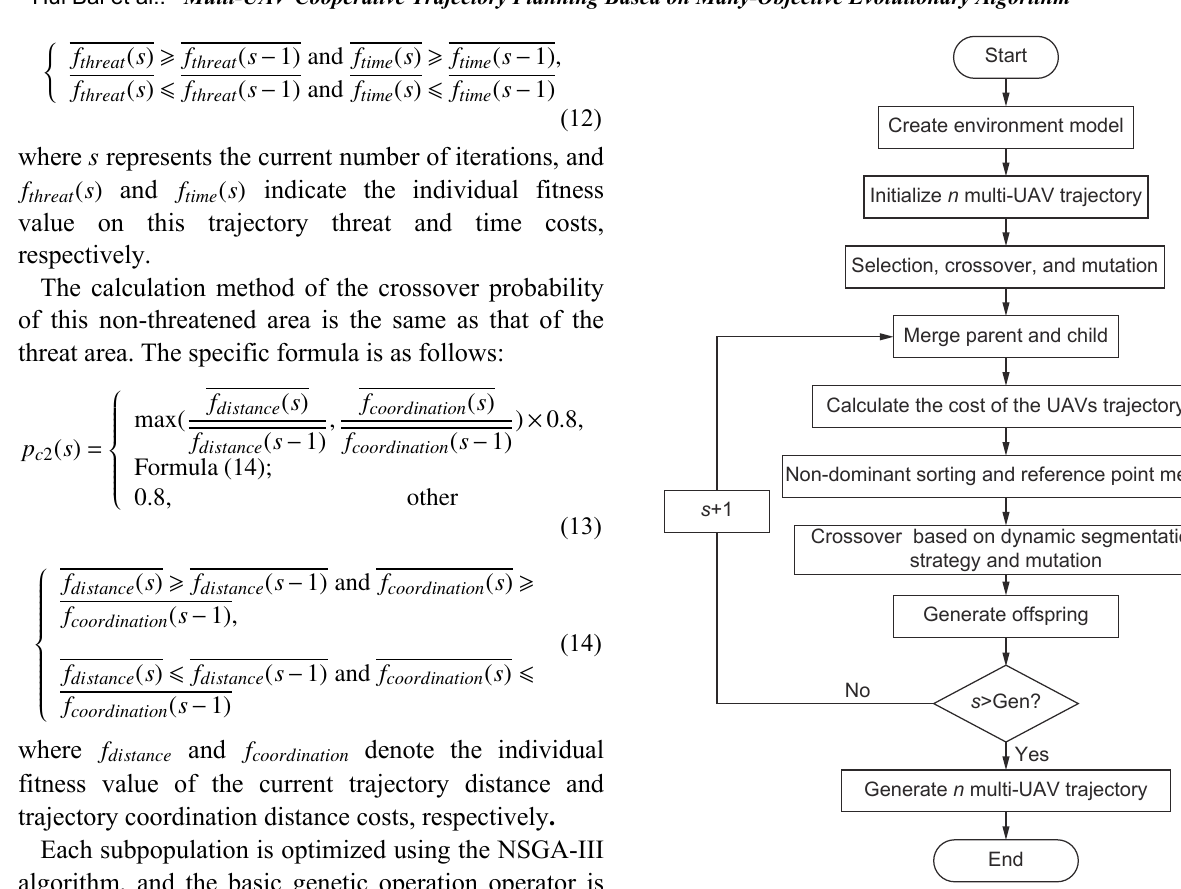
Fig. 2 Algorithm flowchart based on multi-UAV trajectory